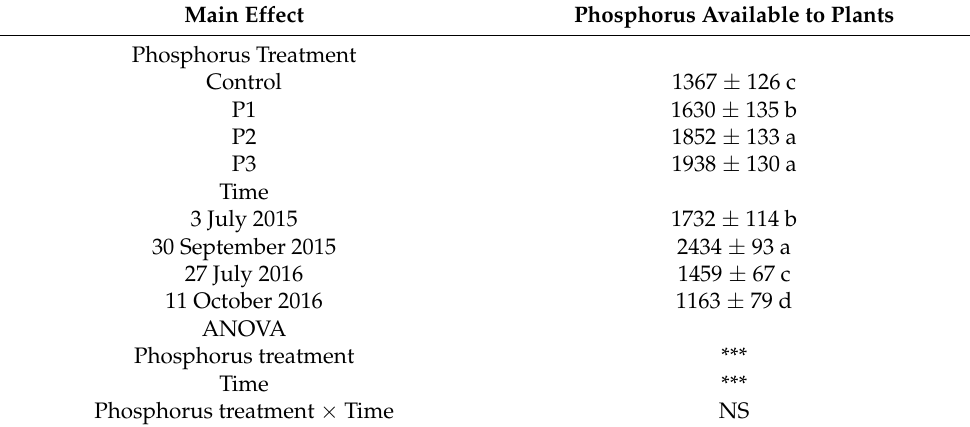
Table 2. The average content ± standard error (n = 20) of phosphorus available to plants (mg P 2 O 5 L − 1 substrate) regarding phosphorus treatment and time of sampling.